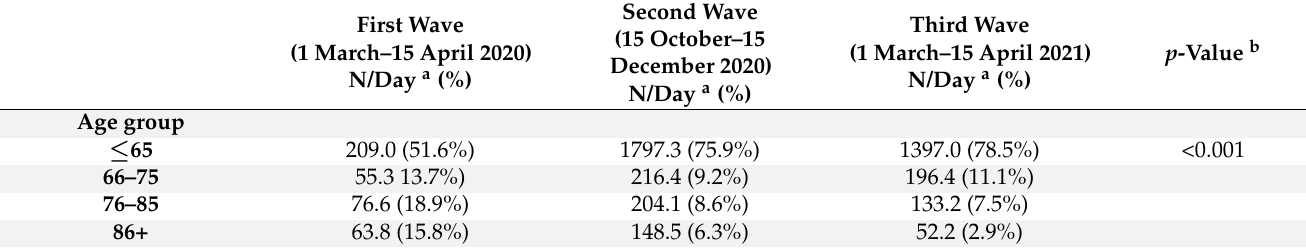
Table 1. Demographic characteristics, comorbid conditions, hospitalization, intensive care unit (ICU) admission, and death from COVID-19 of subjects tested positive for SARS-CoV-2, stratifying by